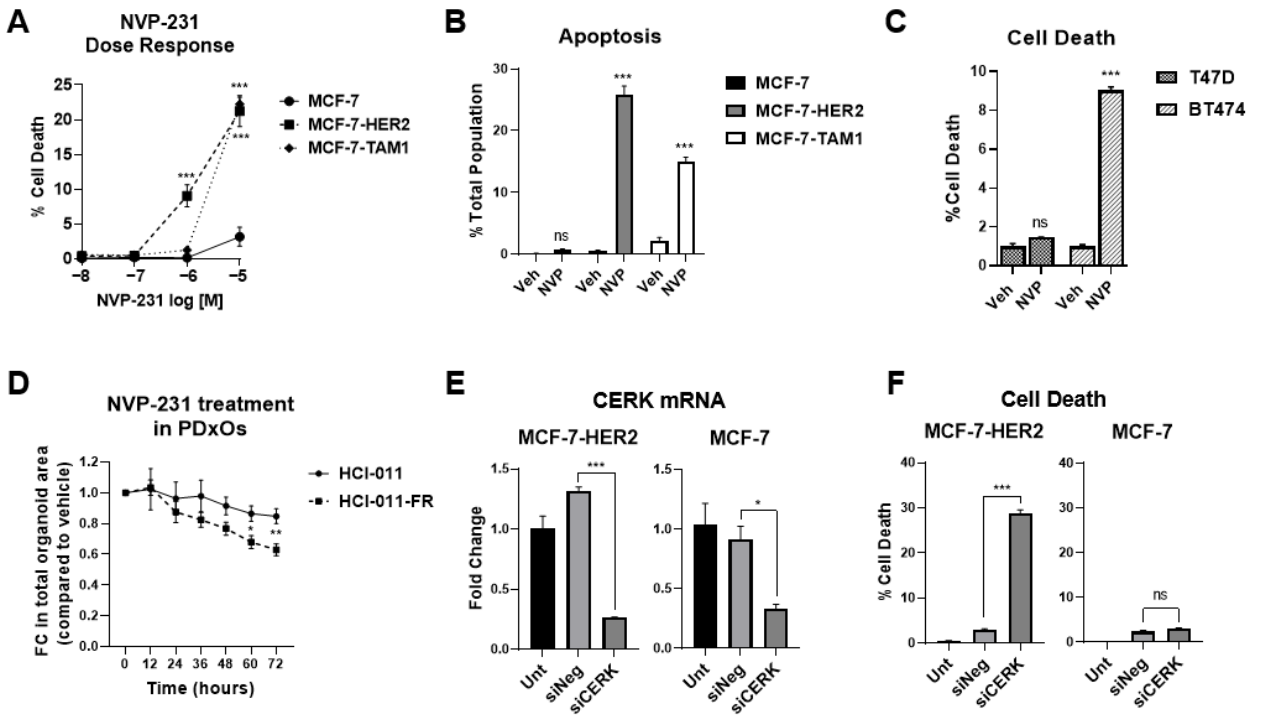
Figure 2. Endocrine therapy-resistant cells rely on CERK for survival. ( A ) MCF-7, MCF-7-HER2, and MCF-7-TAM1 cells were treated with increasing doses of NVP-231 for 48-h. Cell death was assessed by Hoechst-PI staining. ( B ) Annexin-V-positive and PI-positive cells were analyzed following a 48-h treatment of 1 µ M and 10 µ M NVP-231 to assess apoptosis. The percentage of apoptotic cells were calculated as the number of Annexin-V and PI-positive cells times 100 over total number of cells, as assessed by Hoechst counterstain. ( C ) T47D and BT474 cells were treated with 10 µ M NVP-231 for 48-h. Cell death was assessed by Hoechst-PI staining. ( D ) Fulvestrant-sensitive (HCI-011) and -resistant (HCI-011-FR) PDxOs were treated with 10 µ M NVP-231 for 72-h. Organoid growth was analyzed by measuring total organoid area. Data points are represented as fold changes in total organoid area by NVP-231 related to vehicle at each time point. ( E , F ) CERK was knocked down by a validated siRNA in MCF-7-HER2 and MCF-7 cells. An untransfected control and a non-specific siNeg-transfected control were included for each cell line. Cells were harvested after 72-h of transient transfection. RT-qPCR for CERK mRNA was performed to validate knockdown ( E ) and Hoechst-PI endpoint assay was performed to estimate cell death ( F ). ns: not significant, * p < 0.05, *** p < 0.001.